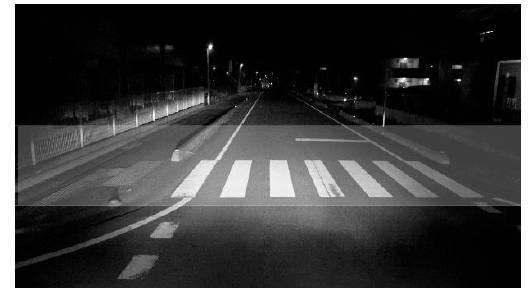
Figure 7 . Trimming range.